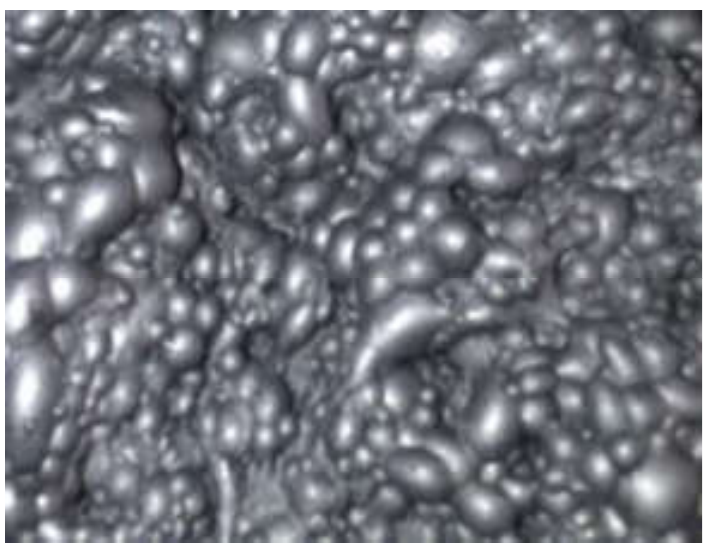
Figure 4. Probability statistical distributions of optimal froth image features. Table 5. Optimal intervals of froth image features.